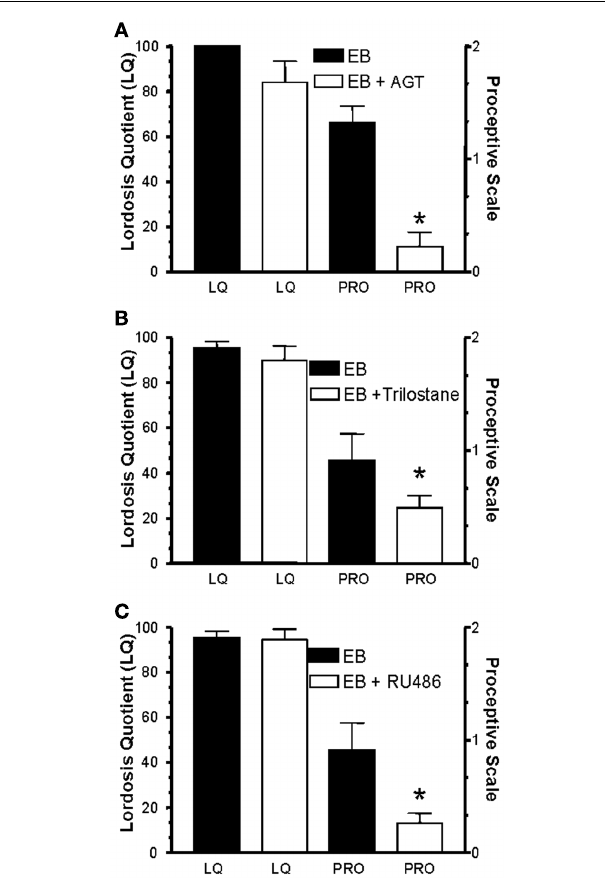
FIGURE 1 | Effects of blocking the synthesis of progesterone and progesterone receptors in the CNS on sexual behavior. Blocking either progesterone synthesis (A,B) with aminoglutethimide (AGT) or trilostane (TRI) or activation of progesterone receptors (C) with RU486 reduces expression of proceptive behaviors, but has no effect on expression of lordosis in OVX/ADX rats treated every 4days with 10 μ g 17 β -estradiol benzoate (EB) and then 1h before the test with EB and drug. Animals were tested 53–56h after the initial EB injection for sexual receptivity, as measured by lordosis quotient (LQ; Beach, 1948; Beach and LeBoeuf, 1967) and expression of proceptive behaviors (proceptivity scale;Tennent et al., 1980).Treatments to block progesterone synthesis or progesterone receptors were delivered subcutaneously and started just before the EB treatment and on the following mornings before testing. AGT (10mg per treatment) blocks P450 side chain cleavage that converts cholesterol to pregnenolone (A) ;TRI blocks the enzyme 3 β -hydroxysteroid dehydrogenase (16.5mg per treatment; 3 β -HSD) which converts pregnenolone to progesterone (B) . RU486 (5mg per treatment) is a progesterone receptor antagonist (C) . Data are means ± SEM of 12 animals. * Represents significantly less than control treatment within behavior group as determined by Mann–Whitney, where p > 0.05 (from Micevych et al.,